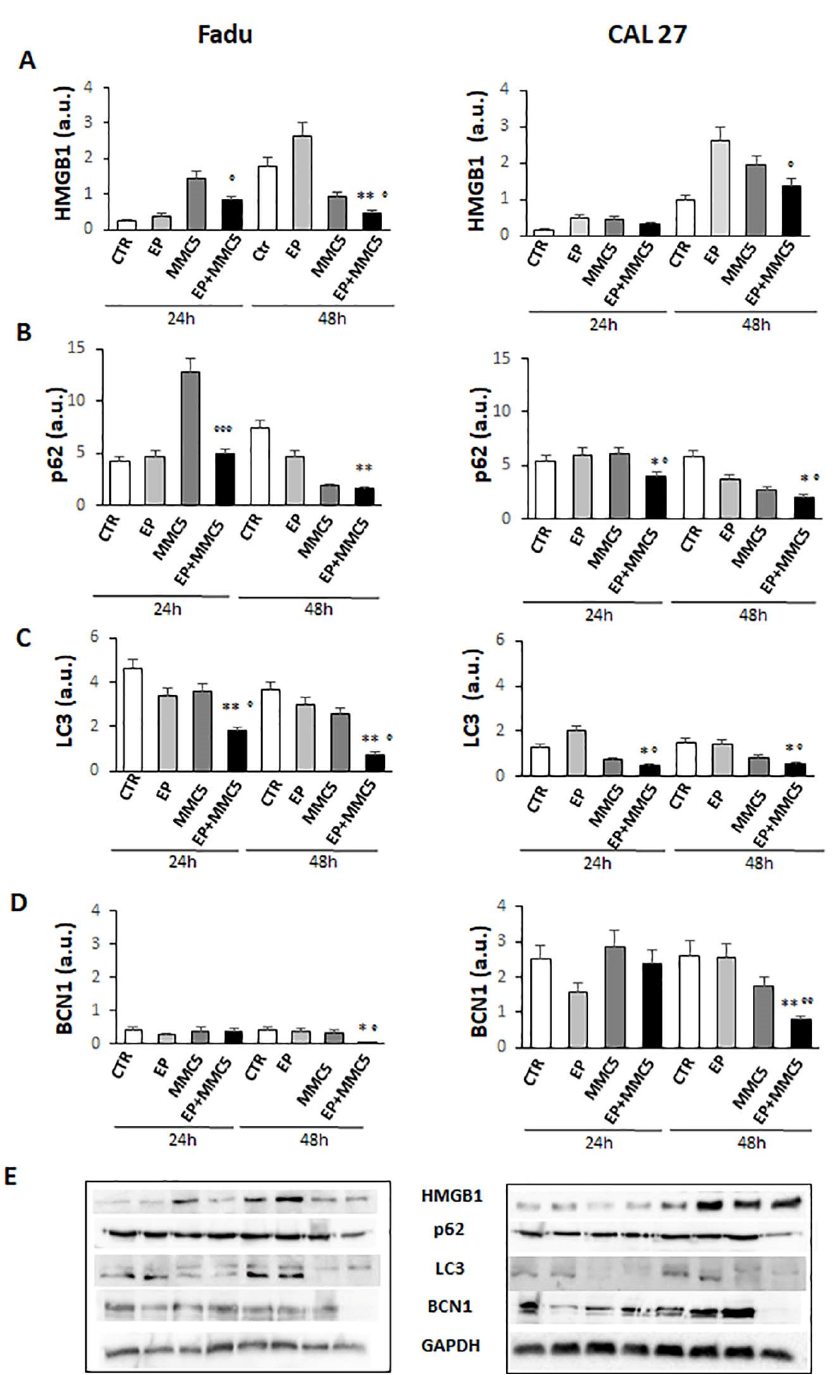
Figure 11. Autophagic pathway. The bar graphs show the quantification of relative densitometry of HMGB1 ( A ), p62 ( B ), LC3 ( C ), and BCN1 ( D ) in the FaDu (left panel) and CAL 27 cells (right panel). Each protein is normalized to GAPDH. Data are expressed as the mean ± SD of three independent experiments. * p ≤ 0.05 vs. control; ° p < 0.05 with respect to MMC; ** p ≤ 0.01 vs. control; °° p ≤ 0.01 compared to MMC; °°° p ≤ 0.001 compared to MMC ( E ). Representative Western blot analysis of all proteins in FaDu (left panel) and CAL27 cells (right panel). The GAPDH determination was used as load controls. Not - ropped Western blot figures are available in Figures S2 and S3.